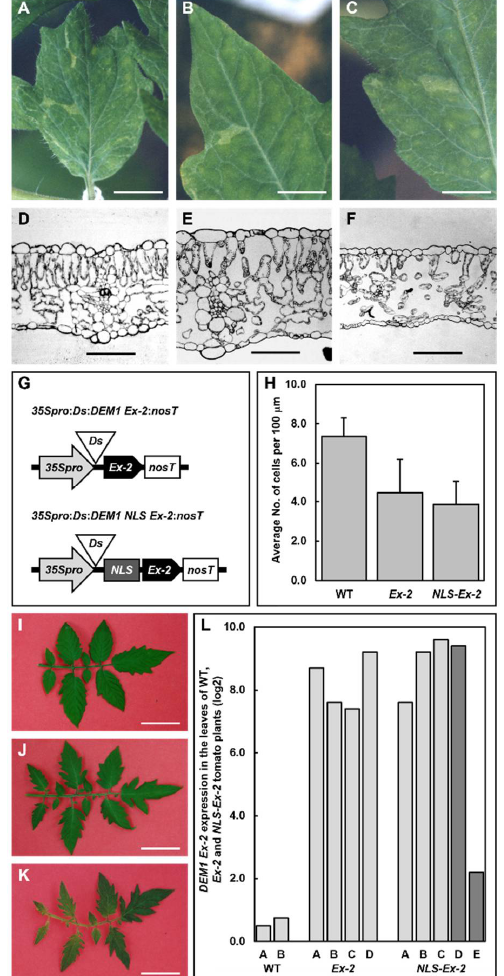
Figure 4. Phenotypes displayed by the Ex-2 and NLS-Ex-2 tomato transformant lines. ( A – C ) Tomato transformant lines constructed to transiently overexpress DEM1 exon-2 only ( Ex-2 plants) or DEM1 exon-2 together with the putative nucleus localization signal (NLS) of DEM1 ( NLS-Ex-2 plants) developed leaf sectors similar to those observed for SMD leaves. ( D – F ) Transverse sections of dem1 mutant sectors of Ex-2 ( E ) and NLS-Ex-2 ( F ) leaves clearly show that palisade mesophyll cell formation is intermittent, and that spongy mesophyll proliferation is almost absent, compared to the uniform formation of these two cell types in WT tomato leaves ( D ). ( G ) Schematic of the DEM1 overexpression transgenes 35Spro : Ds : DEM1 Ex-2 : nosT and 35Spro : Ds : NLS DEM1 Ex-2 : nosT introduced into tomato plants to generate the Ex-2 and NLS-Ex-2 transformant lines, respectively. ( H ) Adaxial epidermal cell counts per 100 µ m section across a 600 µ m interval revealed that cell size was reduced (not statistically significant) in dem1 mutant sectors of Ex-2 and NLS-Ex-2 leaves compared to WT leaf sectors. ( I ) The majority of Ex-2 and NLS-Ex-2 transformants which stably overexpressed DEM1 -derived sequences developed leaves of WT appearance. ( J ) A small number of stable Ex-2 transformants did however develop leaves with a decreased blade width and deeper degrees of margin serration. ( K ) Similarly, a small number of stable NLS-Ex-2 transformants developed abnormal leaves with wrinkled blades, dull green coloration, and deeply serrated margins. ( L ) RT-qPCR revealed that the degree of SlDEM1 overexpression in Ex-2 and NLS-Ex-2 transformant lines did not correlate with the level of severity of the leaf phenotype displayed by some NLS-Ex-2 transformants (dark grey columns) when compared to the level of DEM1 overexpression in stable Ex-2 and NLS-Ex-2 transformants which did not display leaf phenotypes (light grey columns). Scale bars = 1000 µ m ( A ), 500 µ m ( B ), 250 µ m ( C ), 100 µ m ( D – F ), and 2.5 cm ( I , J